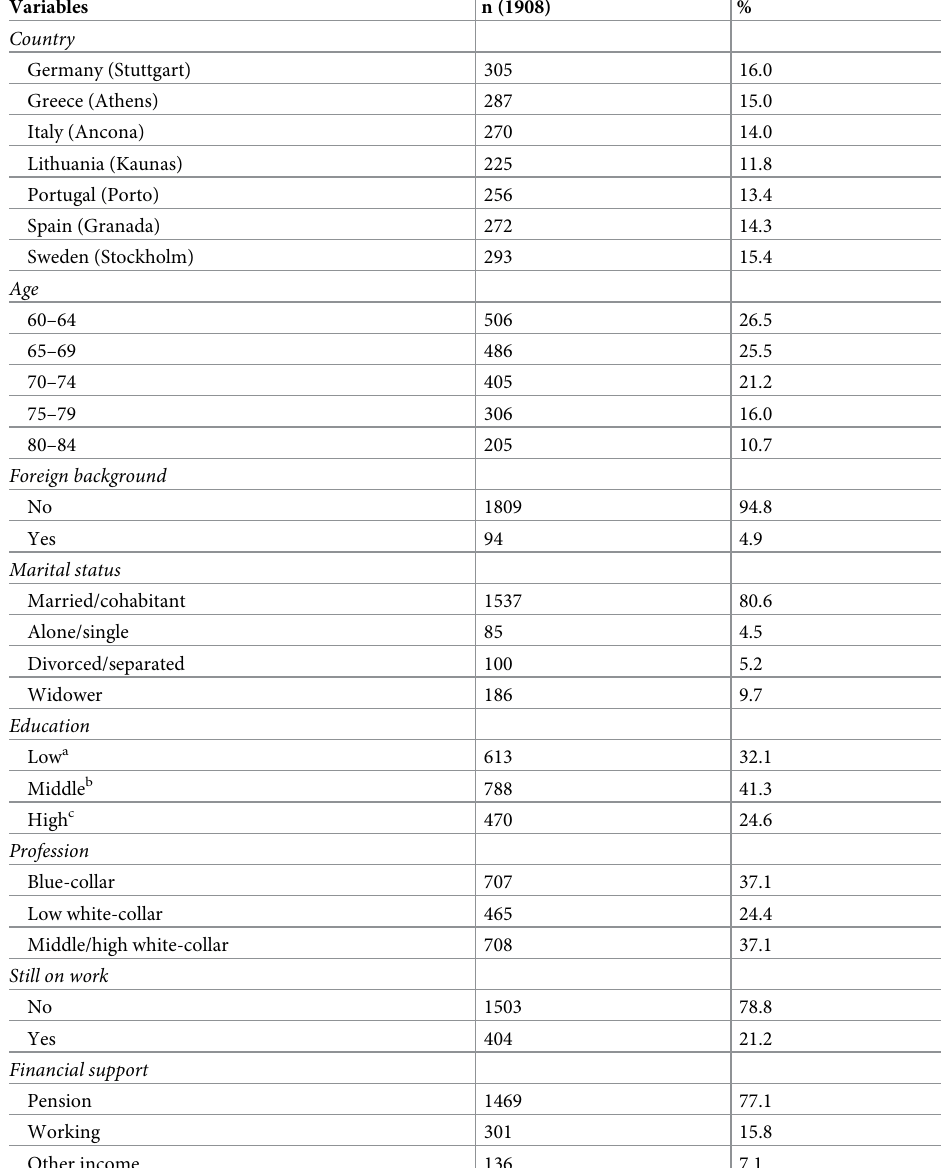
Table 1. Demographic/socio-economics, lifestyle and health characteristics of older